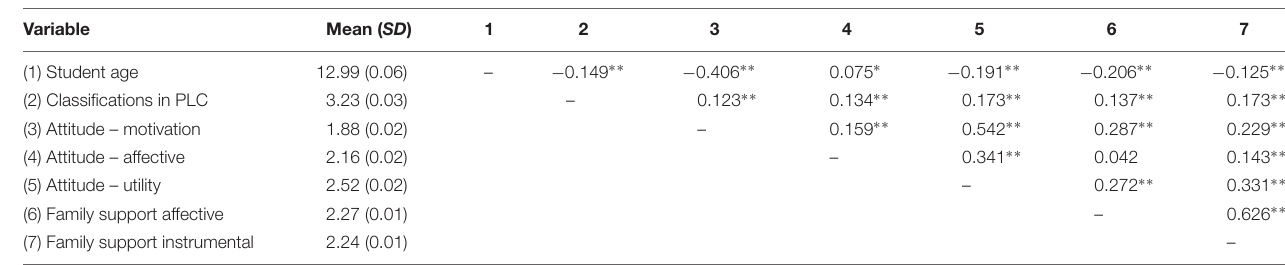
TABLE 1 | Descriptive statistics and Zero-order correlation among study variables.